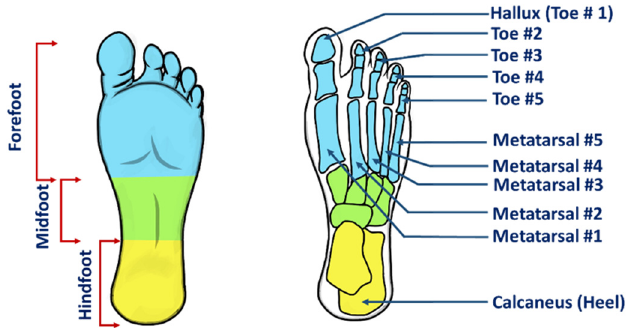
Figure 2. Foot regions commonly investigated in PPD studies.